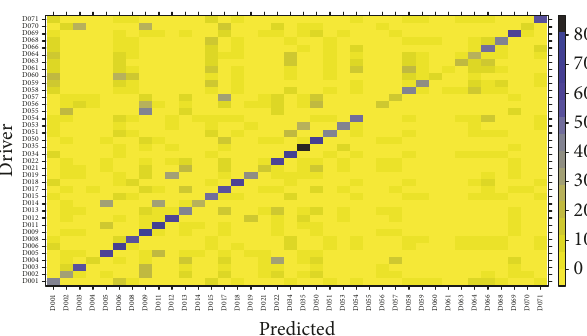
Figure 4: Accuracy and classification obtained for all 38 drivers taken together in a single